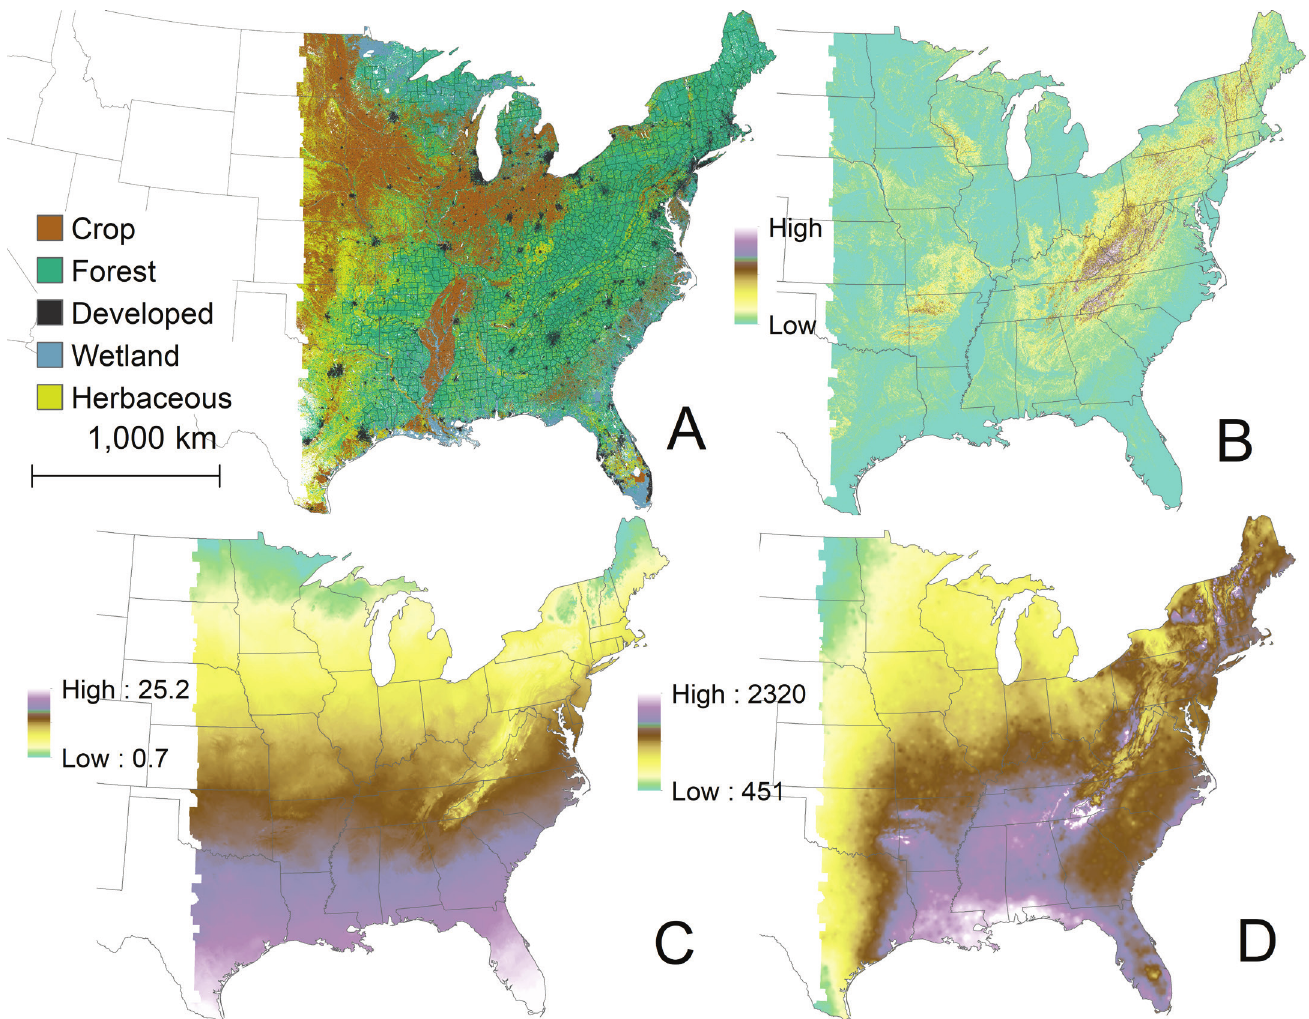
Figure 1. The study extents of the eastern U.S. and eastern forests (green) with land cover classes (A; 2016 land cover; Homer et al. 2020), topographic roughness (B; smaller values equal flatter areas with less topographic difference; Amatulli et al. 2020), mean annual temperature (C; °C; 1991–2020; PRISM Climate Group 2022), and total annual precipitation (D; mm; 1991–2020; PRISM Climate Group